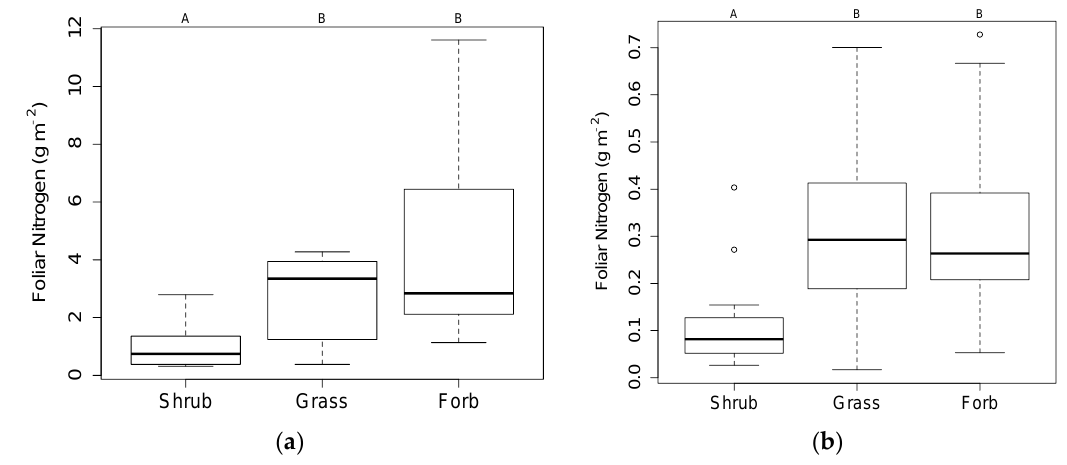
Figure 10. ( a ) Foliar nitrogen per bioswale area ( n = 42); ( b ) Foliar nitrogen per leaf area ( n = 179). The letters at the top represent statistically significant differences among groups (two groups that share a letter are not statistically different).